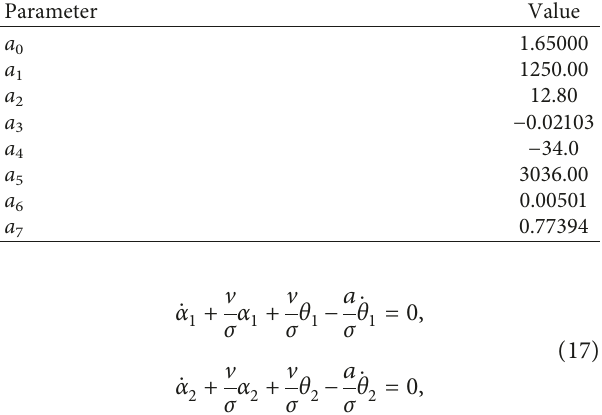
Table 1: Values of the coefficients of Magic